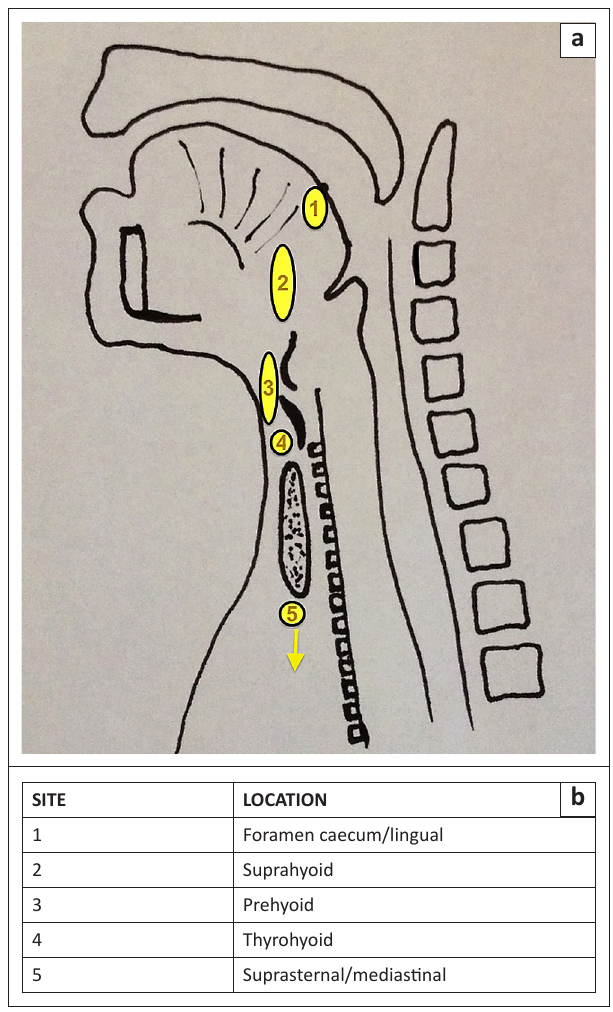
FIGURE 5: (a) Sagittal line diagram showing the common sites of ectopic thyroid rests or thyroglossal cyst formation; (b) Explanation of Figure 5a sites and